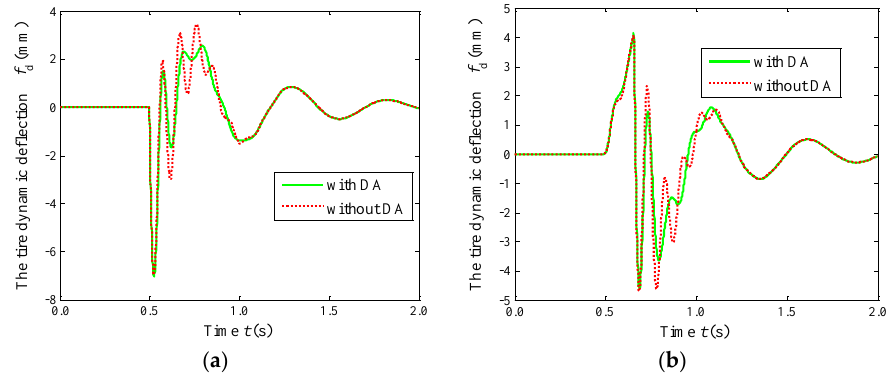
Figure 8. A comparison of the time histories of the tire dynamic deflection f d for the system with the DA and without the DA: ( a ) going up the step; ( b ) going down the